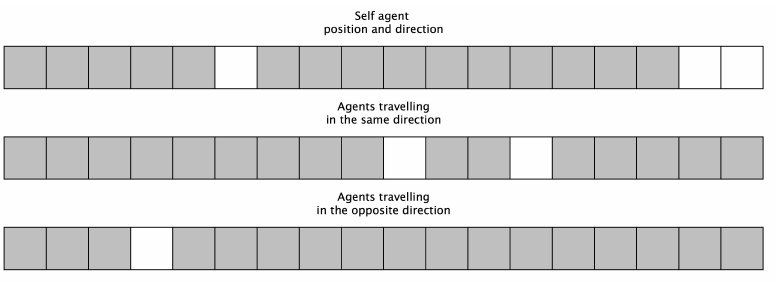
Figure 3. The components of the vector-based state